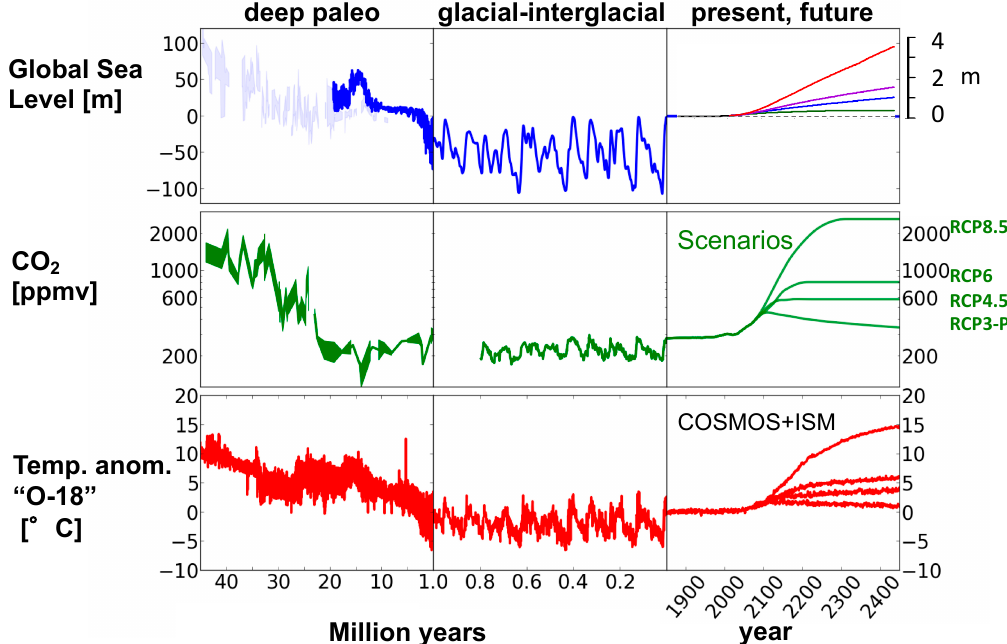
Figure 3. Sea level, CO 2 , and temperature at different time scales. The time scales are called “deep paleo” (50 to 1 million years ago), indicating a cooling trend, glacial–interglacial variability covering the last 1 million years, and, finally, model scenarios for present and future climate evolution with the Earth System Model COSMOS + ISM [7]. Note that future scenarios strongly deviate after the year 2100.